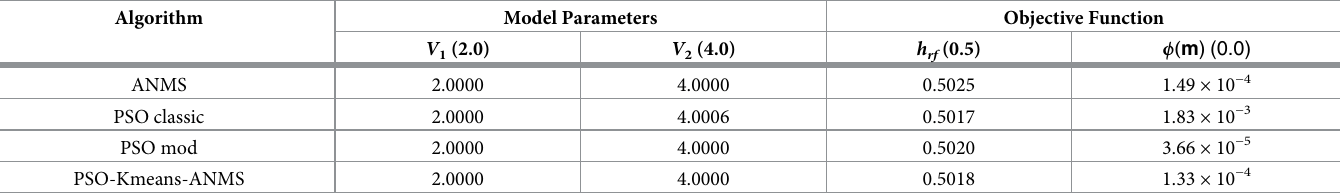
Table 12. Case 2 (50 × 40). Results of model parameters and the respective objective function (misfit) for the best solutions obtained in each optimization algorithm. Algorithm